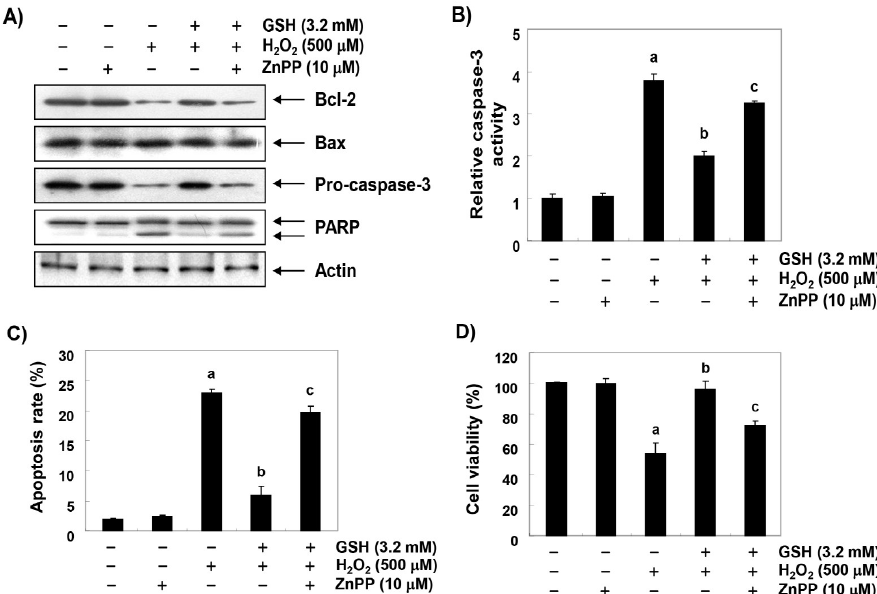
Figure 7. Effects of glutathione on the expression of apoptosis regulatory genes in H 2 O 2 -treated RAW 264.7 cells. ( A ) After a treatment with 3.2 mM glutathione or 10 μM ZnPP in the presence or absence of H 2 O 2 for 24 h, the cellular proteins were prepared, and the protein levels were assayed by Western blot analysis using an ECL detection system. Actin was used as an internal control. ( B ) The cells were lysed, and aliquots were assayed for in vitro caspase-3 activity using DEVD-pNA as substrates. The amount of pNA released was measured at 405 nm using an ELISA microplate reader. ( C ) To quantify the degree of apoptosis, the cells were stained with FITC-conjugated annexin V and PI for a flow cytometric analysis. ( D ) Cell viability was examined by MTT assay. The results are the mean ± SD obtained from three independent experiments ( a p < 0.05 compared with the control group; b p < 0.05 compared with the H 2 O 2 -treated group; and c p < 0.05 compared with the glutathione- and H 2 O 2 -treated group).